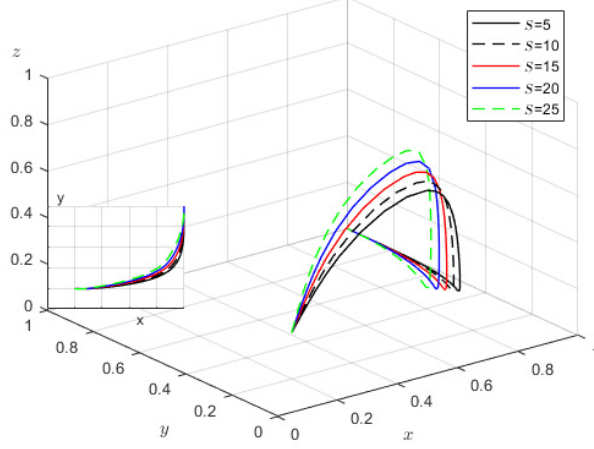
Figure 4. The impact of government’s subsidy.